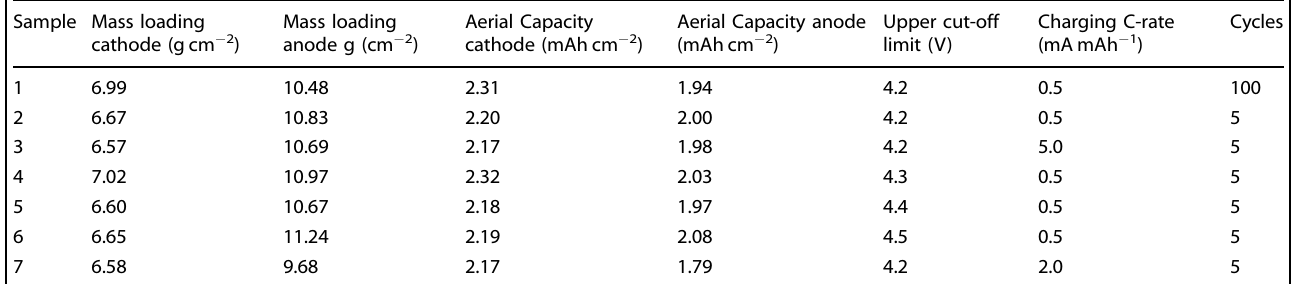
Table 4. Operational cycling parameters for the 7 coin cells.